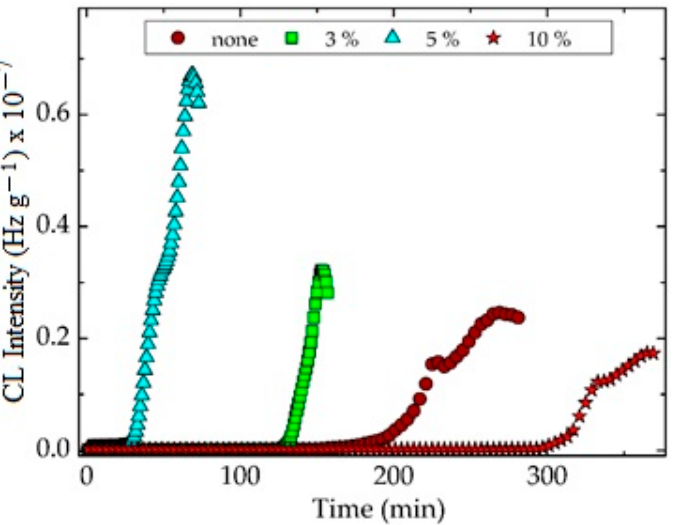
Figure 2. The isothermal CL spectra recorded on nonirradiated PLA/SIS 30 blends modified with silica. Testing temperature: 140 °C.